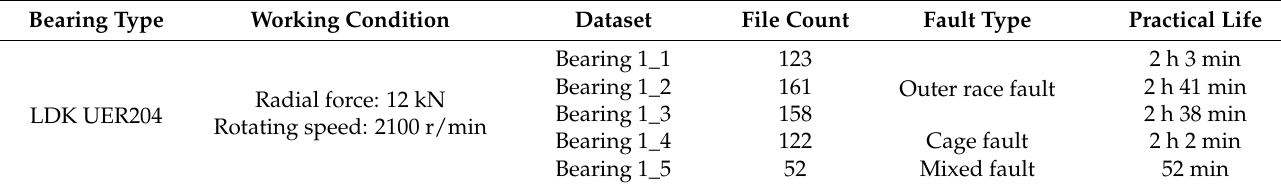
Table 2. Description of the XJTU-SY dataset.